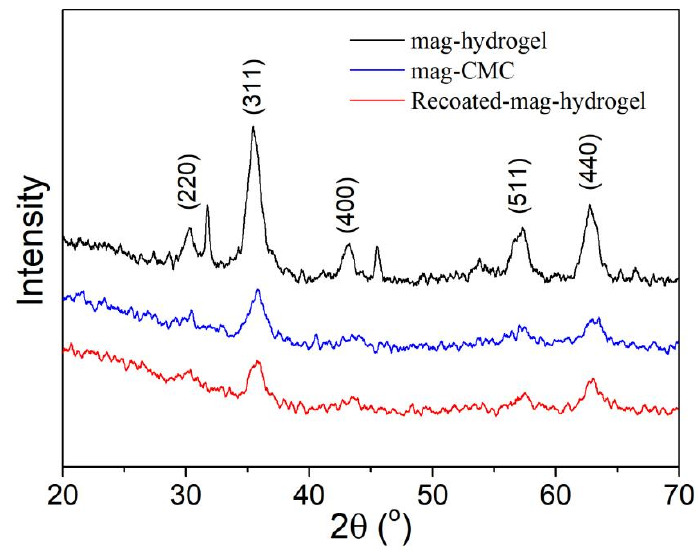
Figure 2. XRD patterns of magnetic nanocomposites.